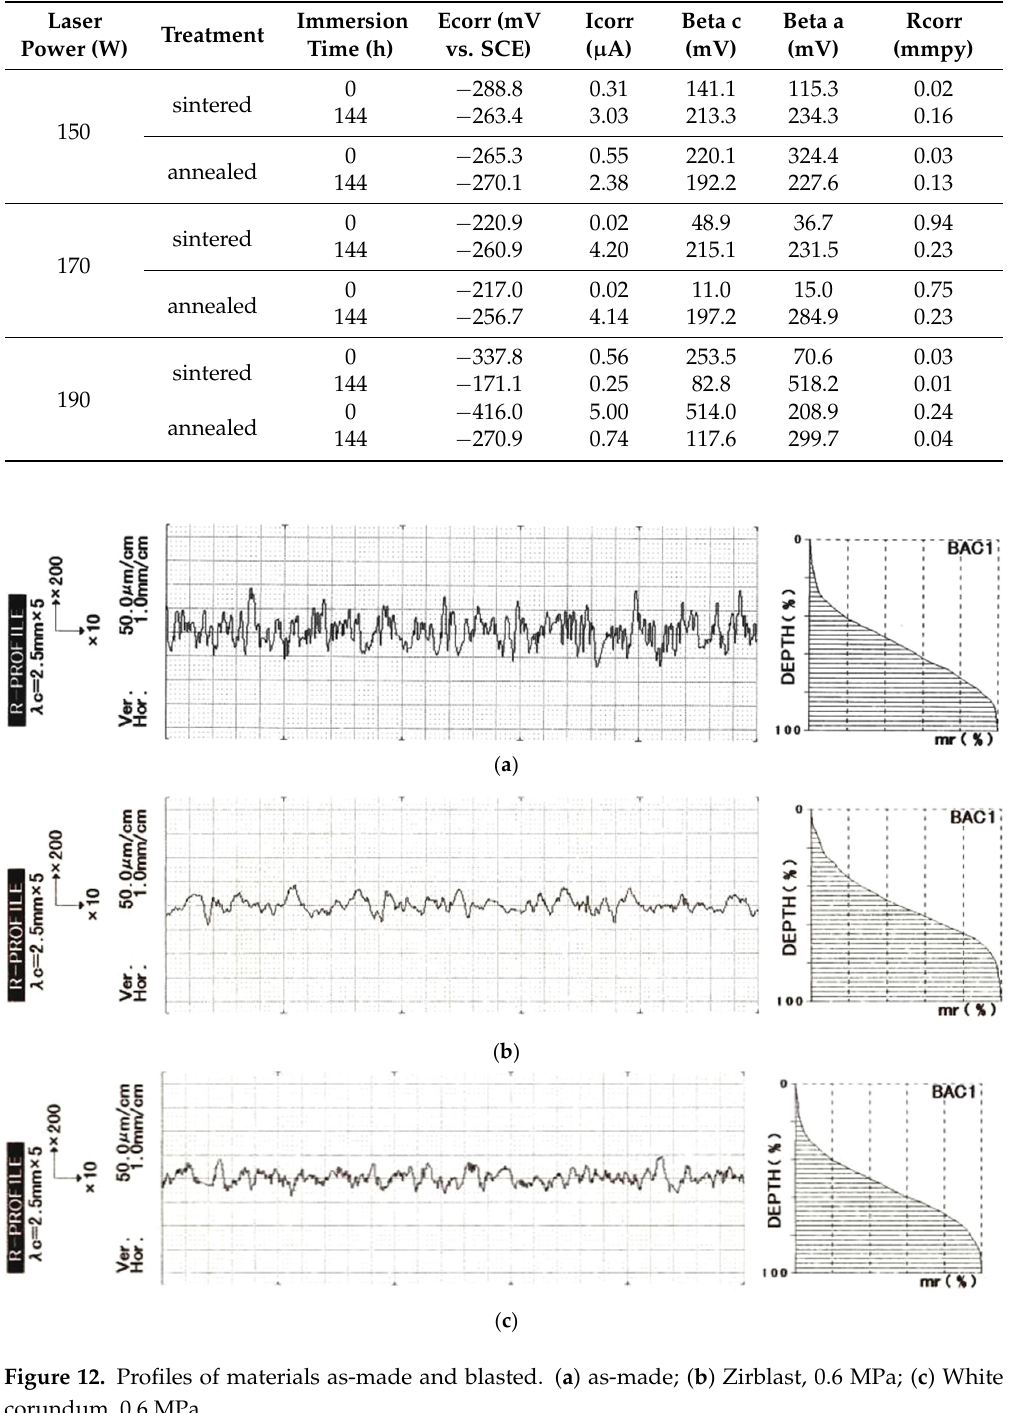
Table 4. Corrosion parameters of investigated materials.